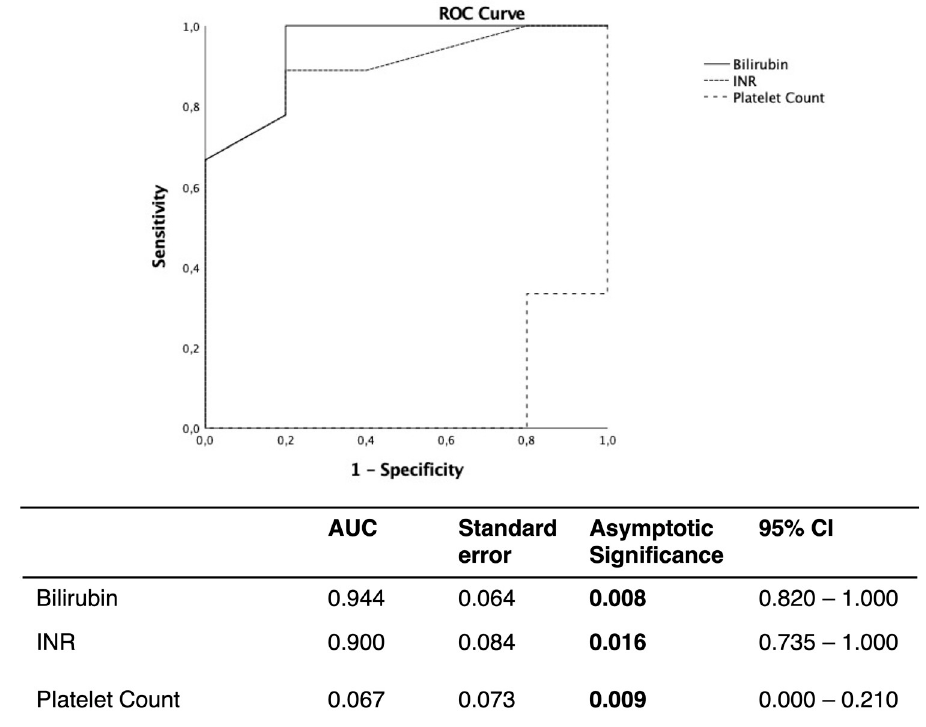
Fig 1. Comparison of receiver operating characteristic (ROC) curves for prediction of 90-day mortality in cirrhotic patients by Bilirubin, INR and platelet count. Bilirubin and platelet count providing an excellent diagnostic capacity. p-values in bold indicate statistical significance. AUC: Area under the curve, CI: Confidence interval, INR: International normalized ratio.